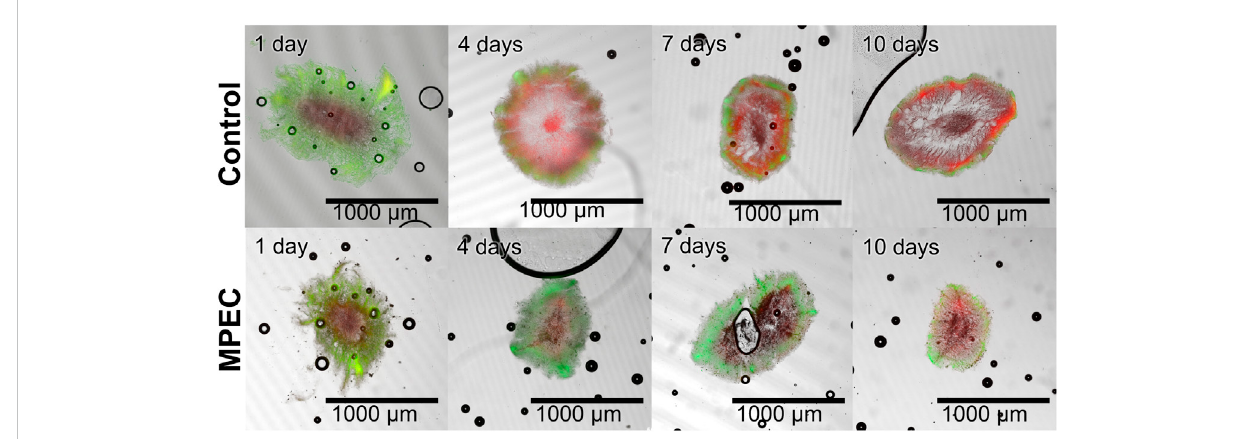
FIGURE 7 Exemplary microscopic images of sliced pellets from unsupplemented cultivation (control) (upper row) and a glass microparticle-supplemented cultivation (10 g · L − 1 , x 50 = 7.9 µm) (lower row) 10-day L. aerocolonigenes cultivation obtained with CLSM. Staining was performed with SYTO9 (green fl uorescence, living cells) and PI (red fl uorescence, dead cells).